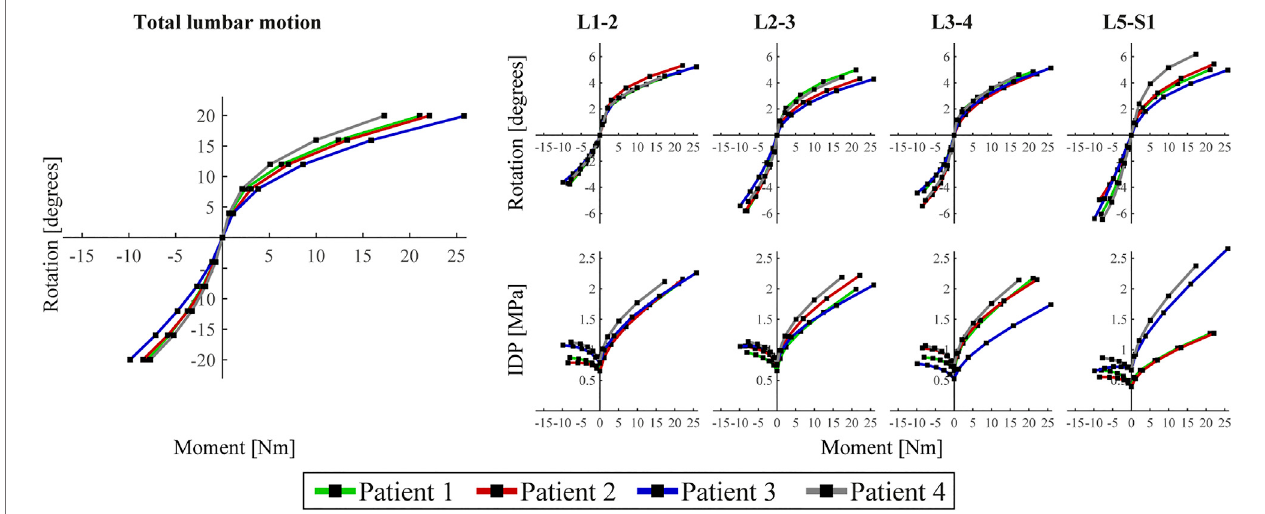
FIGURE2| Left:Load-de fl ectioncurveofthetotallumbarspineforthefourpatient-speci fi cmodels.RotationrepresentsrotationofthecranialendplateofL1inthe sagittalplane andmoment isthereactionmoment required toobtainthese rotationvalues.Right:angularmotionperfunctionalspinal unit(FSU) andintradiscal pressure (IDP) per intervertebral disc (IVD) of the unoperated levels of each of the four patients. For all (sub) fi gures, negative and positive moments/rotations describe extension and fl exion, respectively.